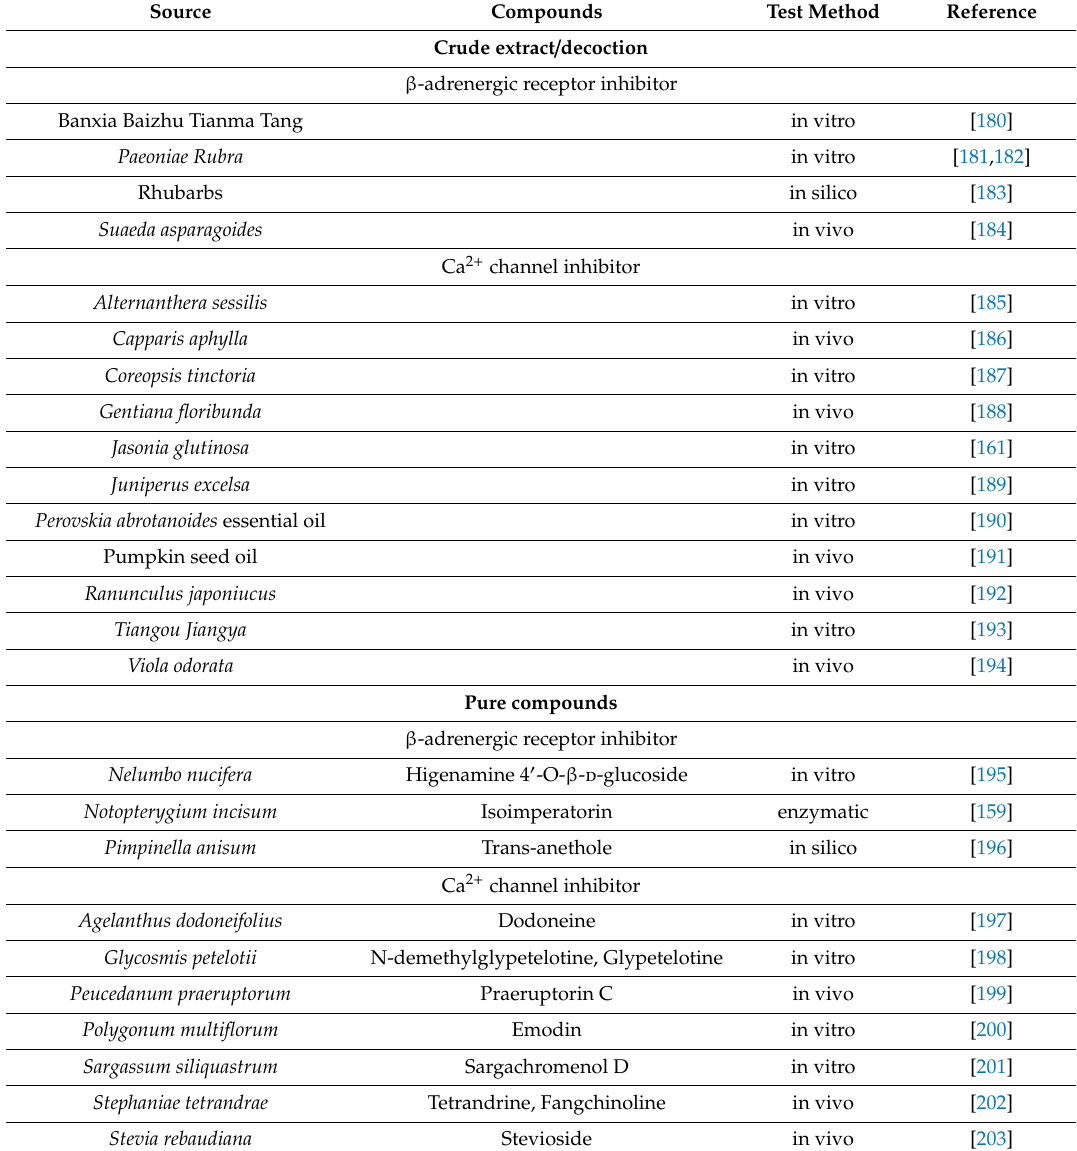
Table 3. Natural source β blockers and Ca 2 +